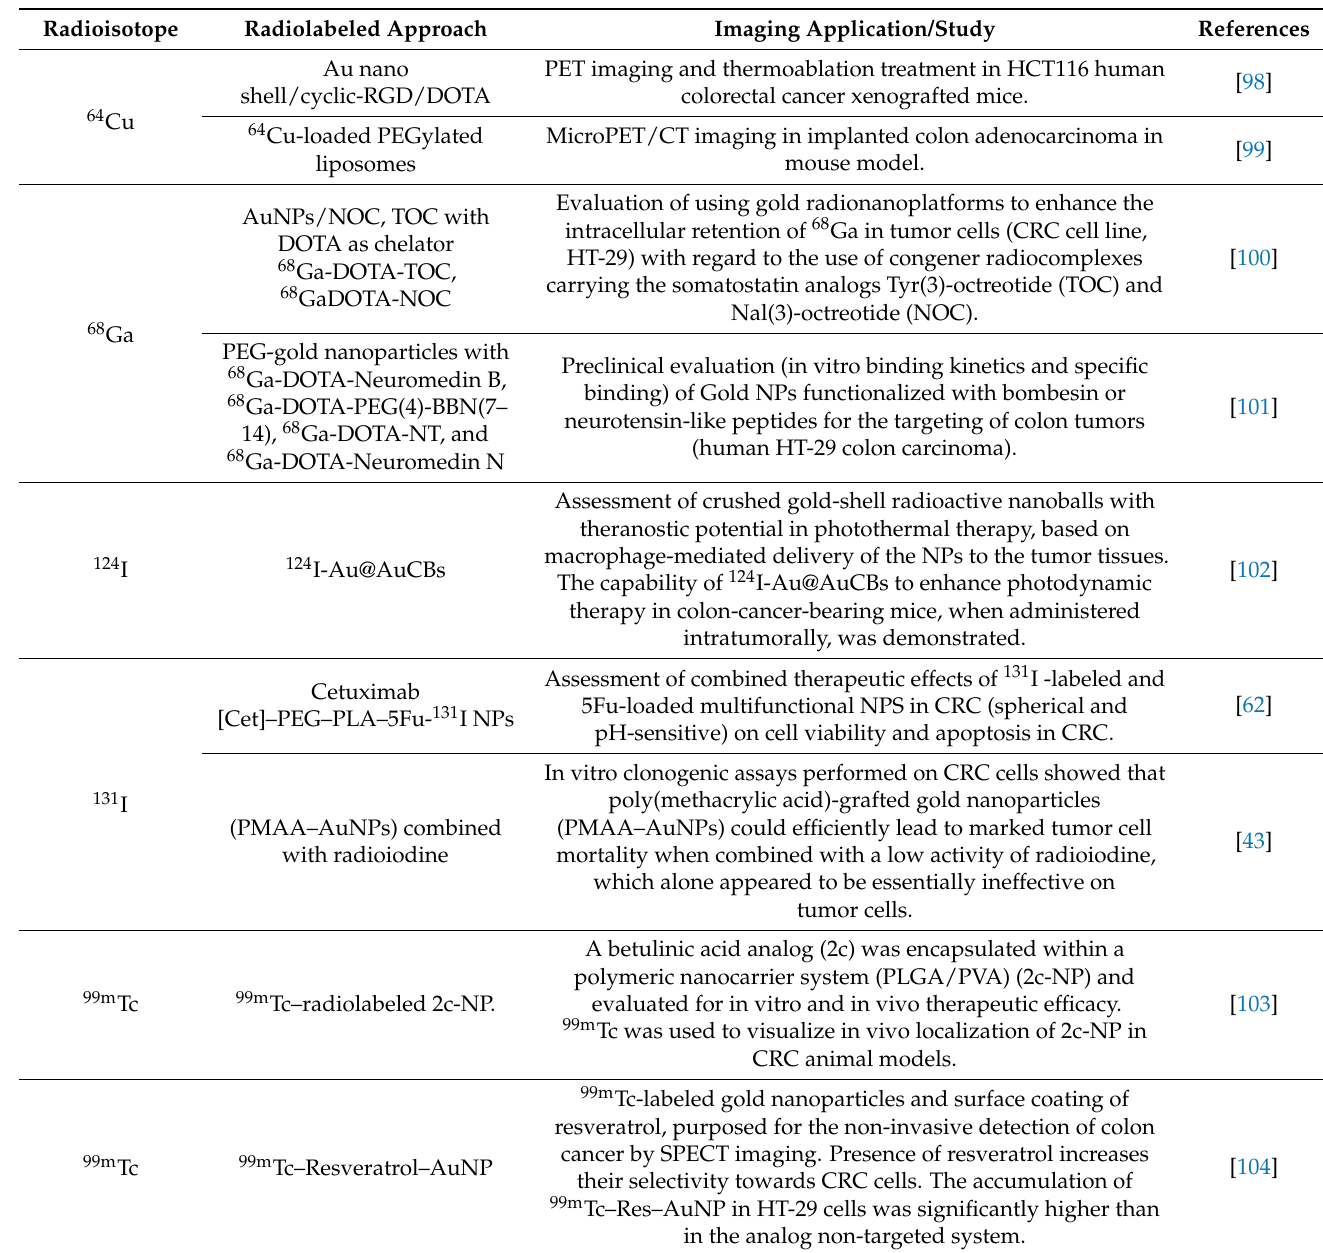
Table 3. Radiolabeled nanosystems for colorectal